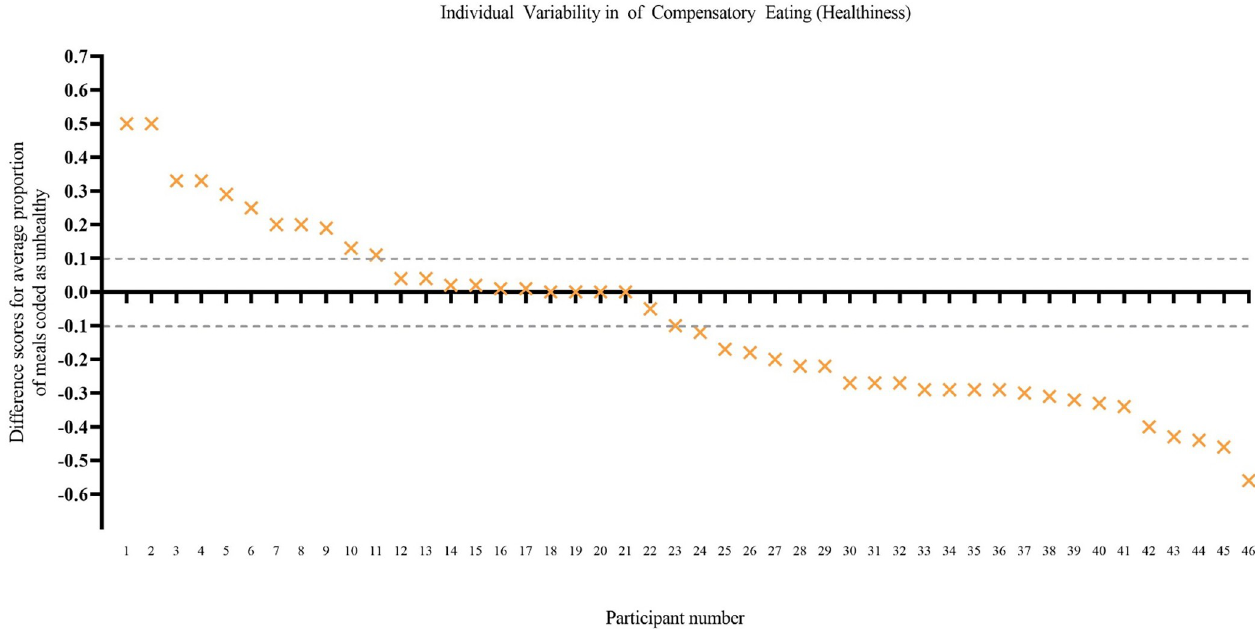
Fig 1. Individual variability in patterns of eating (Study 1). The y axis shows a difference score for each participant: the proportion of post-exercise meals that were unhealthy minus the proportion of random meals that were unhealthy. A positive score indicates that, on average, the participant consumed a greater proportion of unhealthy meals post exercise than at random meals (i.e., compensatory eating). Dotted lines indicate the boundaries ( ± 0.10) used to mark a pattern of eating that was indifferent to exercise (similar proportion of unhealthy meals after exercise and at random meals). Participant scores are ordered in descending order from most compensatory eating to least compensatory eating. Difference scores could only be calculated for 46 of the 48 participants because two did not have any post-exercise meals.